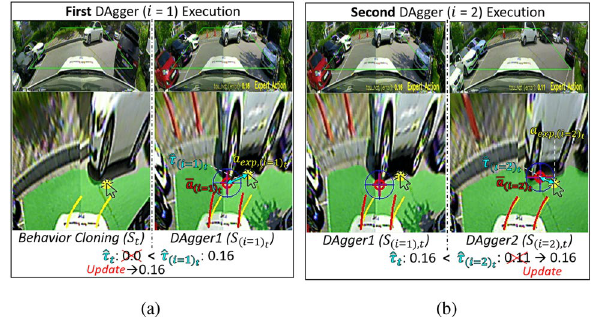
Figure 5. Weight update process ( step 2 ) of WeightDAgger : ( a ) DAgger executed once ( i = 1) ( b ) Action discrepancy ˆ τ ( i = 2 ) still occurs second DAgger iterations ( i = t